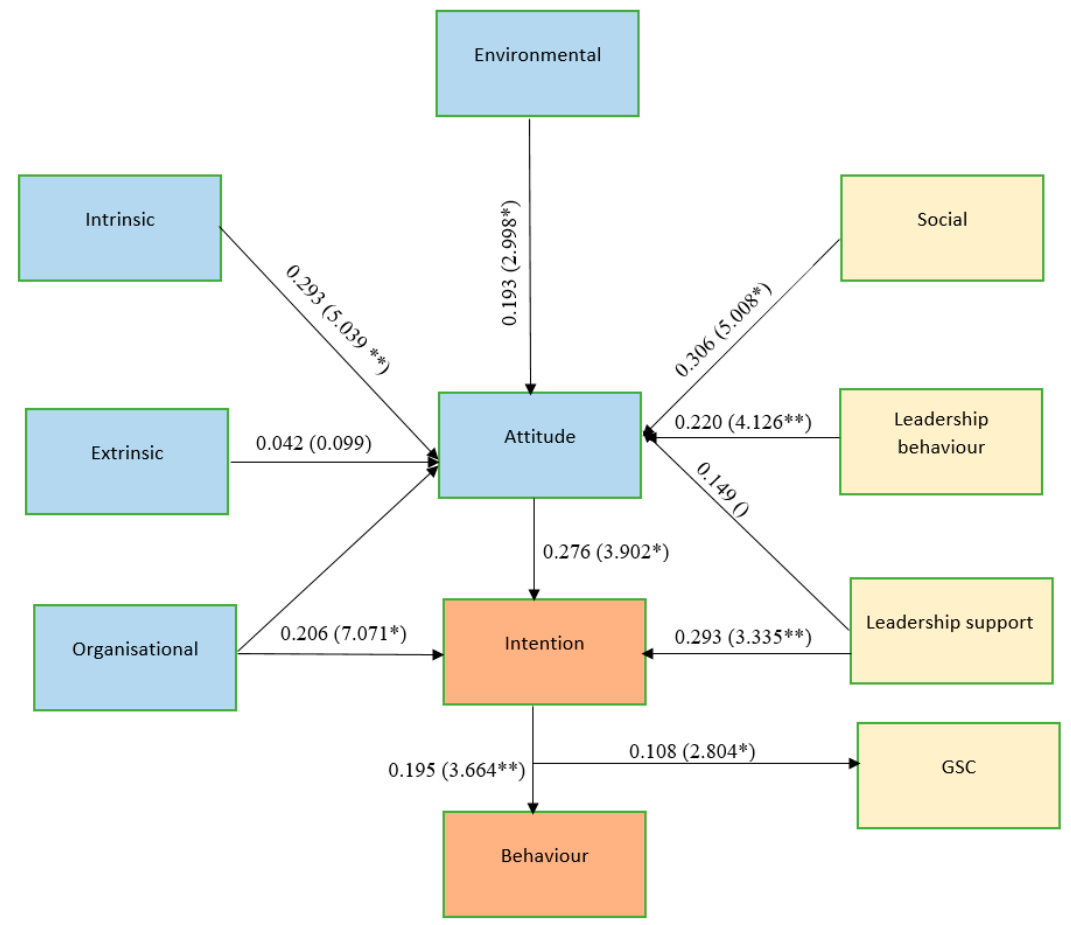
Figure 2. Structural modelling results of the conceptual model * p < 0.01; ** p < 0.05. Figure 3 depicts the moderation plot for green psychological climate.